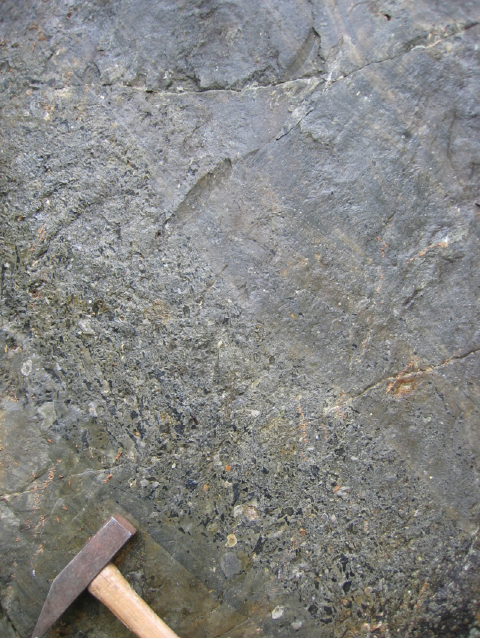
Figure 9. Dunhill Quarry, County Waterford: Ordovician volcanic bedded tuffs.